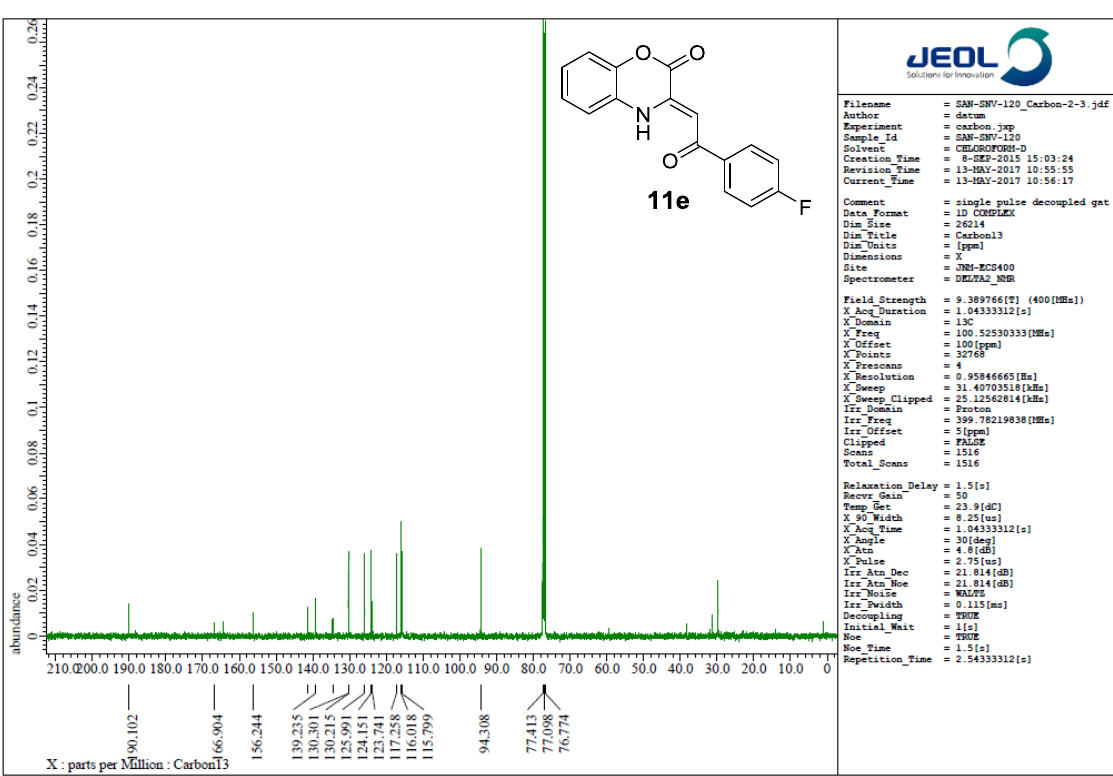
Figure 10. 13 C NMR Spectra of Compound 11e